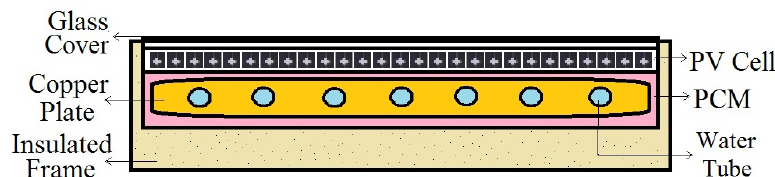
Figure 4. Sectional view of PCM- based PV/T